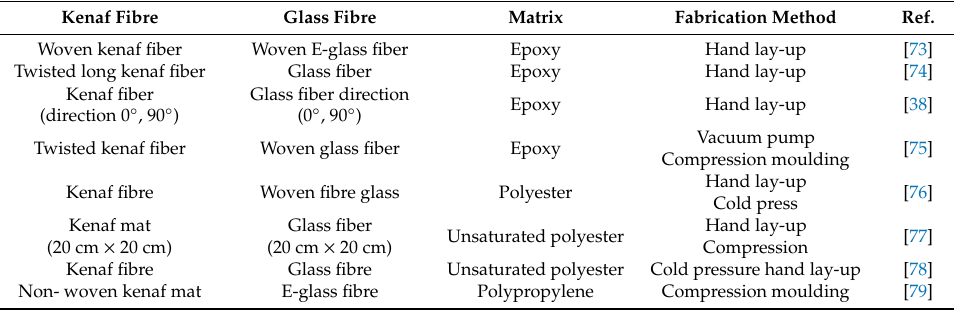
Table 6. Previous studies on kenaf / glass fibre hybrid